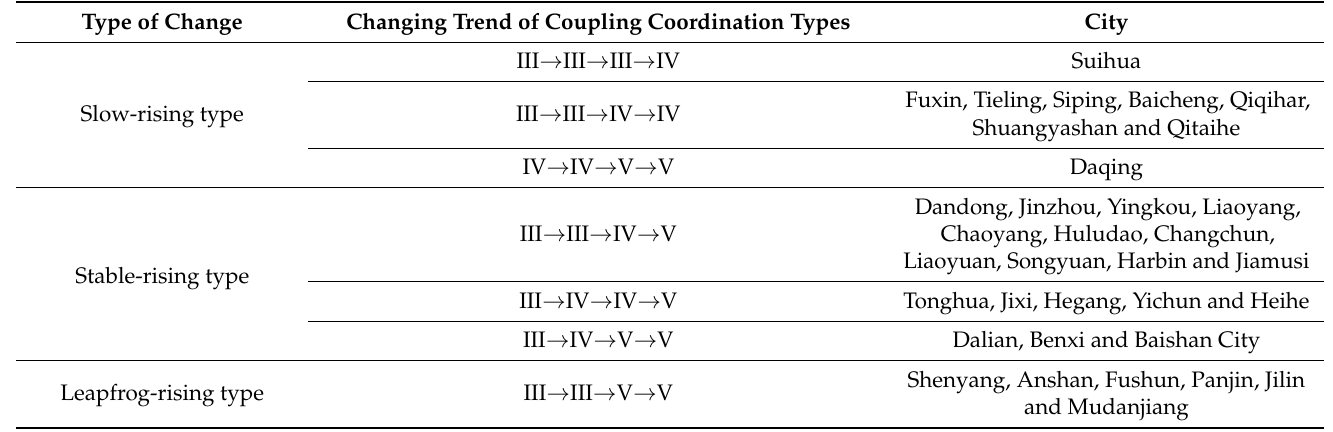
Figure 8. Spatial Distribution of Urban–rural Coupling and Coordinated Development Levels in Northeast China. ( a ) 2000; ( b ) 2006; ( c ) 2013; ( d ) 2019. Table 3. Changes in the Coupling Coordination Types.